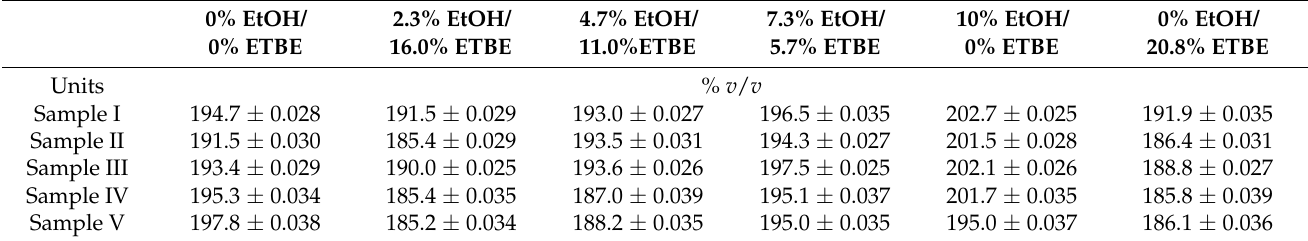
Table 11. Final boiling point of base fuels and bio-EtOH/bio-ETBE blends.